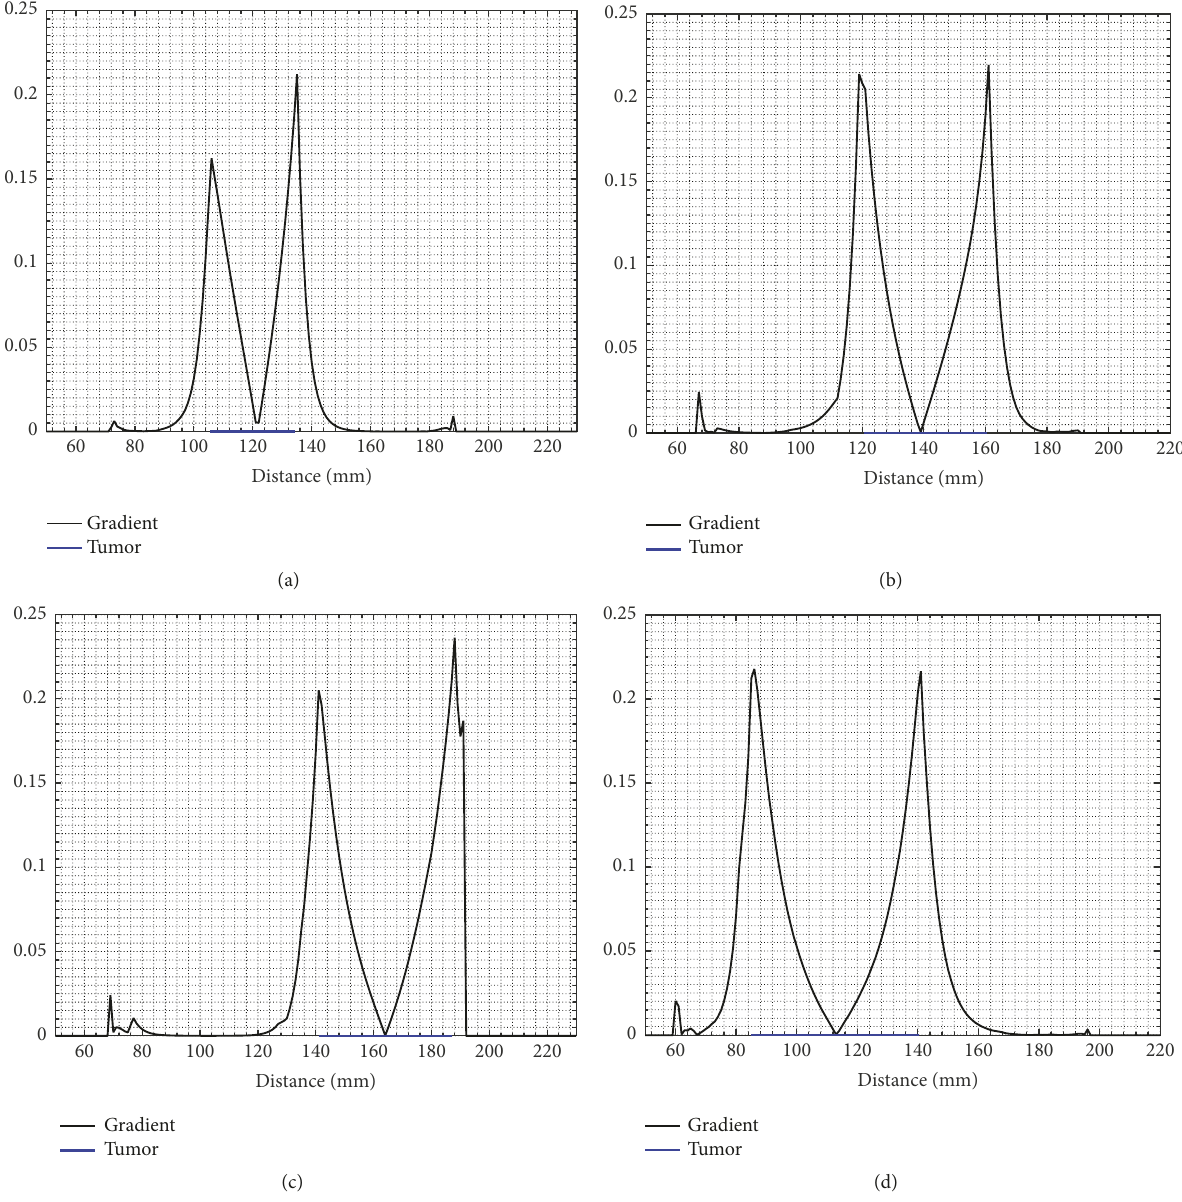
Figure 6: 1D representation of temperature absolute gradient on the path passes in the tumor center in the four cases. (a) Tumor with 11.6 cm3 of volume. (b) Tumor with 27.4 cm3 of volume. (c) Tumor with 51.1 cm3 of volume. (d) Tumor with 81.7 cm3 of